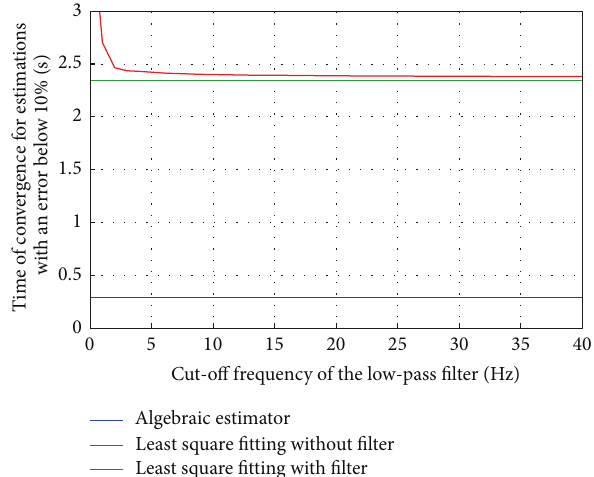
Figure 7: Comparison of the convergence times respect cut- off frequency for the identification of the payload mass 𝑚 3 in experiment type